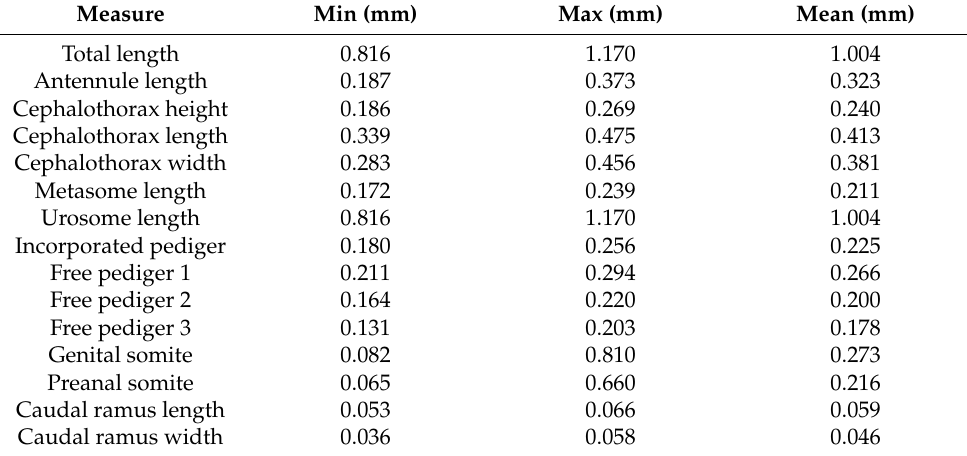
Table 2. Additional measurements of male specimens of Caromiobenella brasiliensis observed in this study